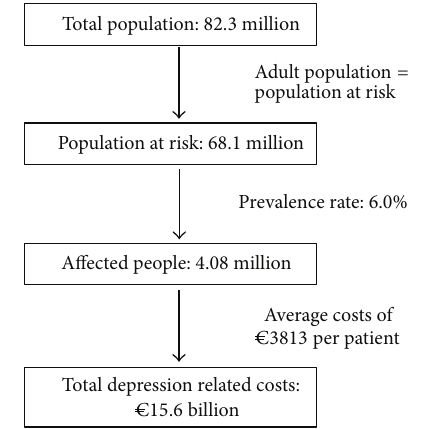
Figure 2: Estimated total costs of depression in